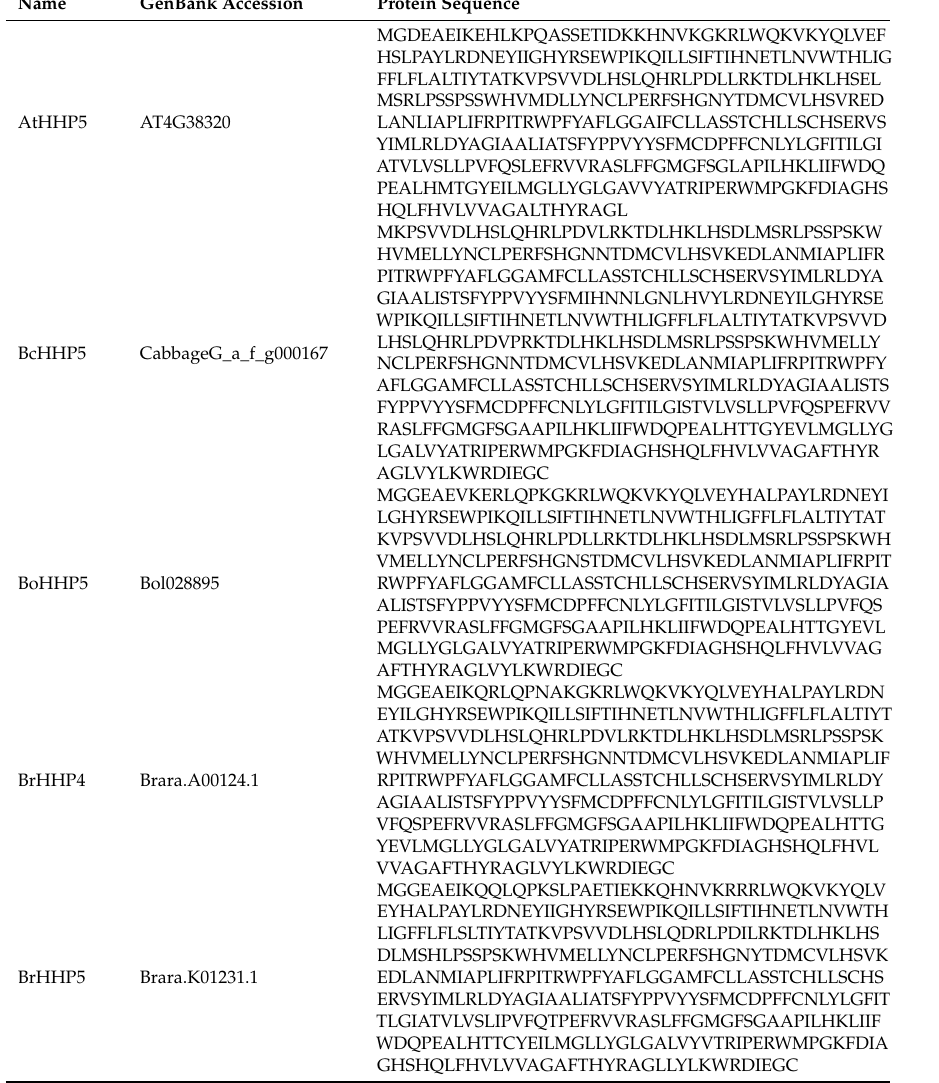
Table 2. HHP protein sequences from some different